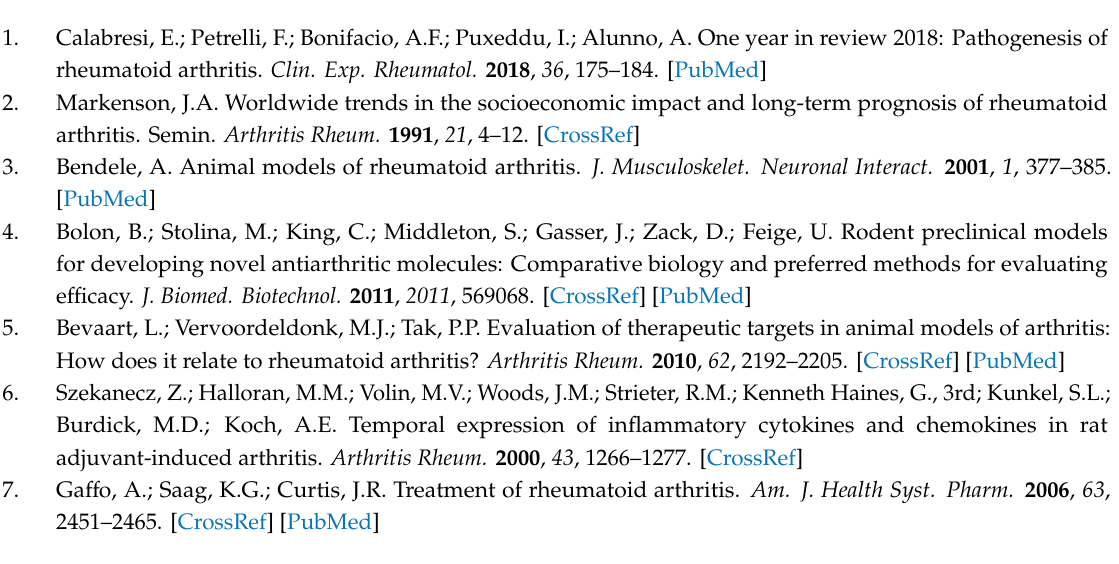
Table S1: E ff ect of Nigella sativa oil on anxiety-like behavior of open filed test in CFA-induced arthritic rats. Author Contributions: C.N. and R.G. designed the research study and revised the manuscript. C.N. performed most of the research study and acquired data. D.F., M.S. and R.S. conducted parts of experiments, acquired and analyzed related data. D.F., C.N., L.B. and M.P. contributed to analysis and interpretation of data. R.G. and